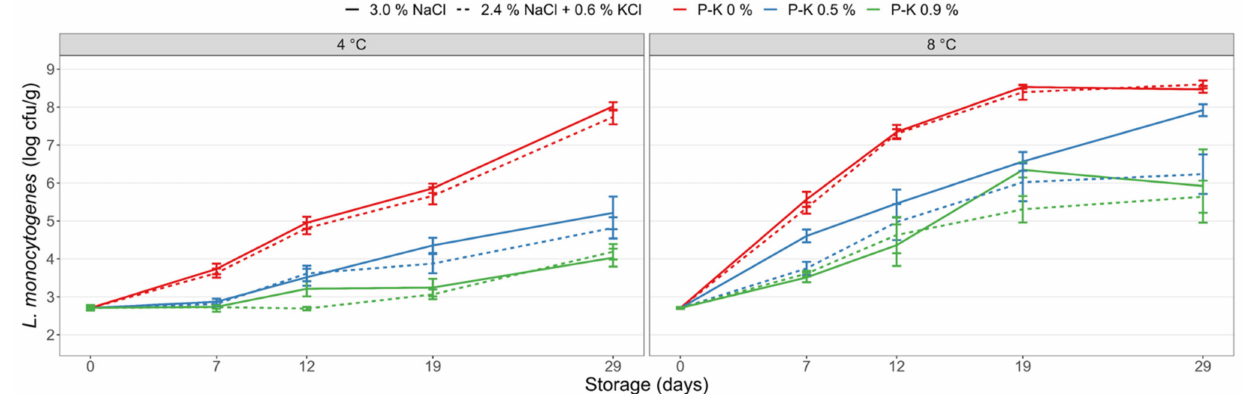
Figure 3. Growth of L. monocytogenes in CS salmon produced with 3% NaCl (control), a sodium- reduced reference salt (2.4% NaCl + 0.6% KCl) and with addition of the preservative salt Provian K. The Provian K salt was added at levels of 0.5% and 0.9% in the salting process. The CS salmon was inoculated with L. monocytogenes at Day 0 and stored under vacuum at 4 ◦ C and 8 ◦ C for 29 days. Mean values of two experiments (four to eight measurements per data point) and standard error of the mean are